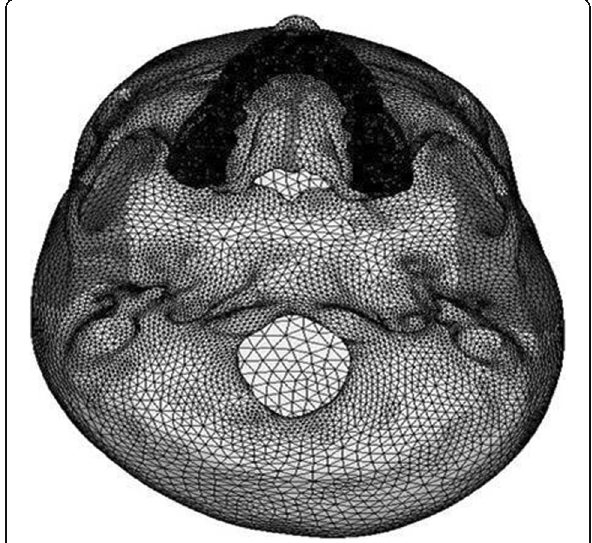
Fig. 4 Basal view of the three-dimensional FE